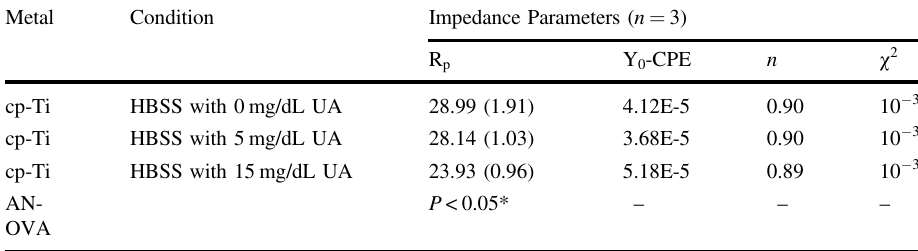
Table 1 Corrosion parameter values for studied cp-Ti exposed to HBSS with different concentrations of uric